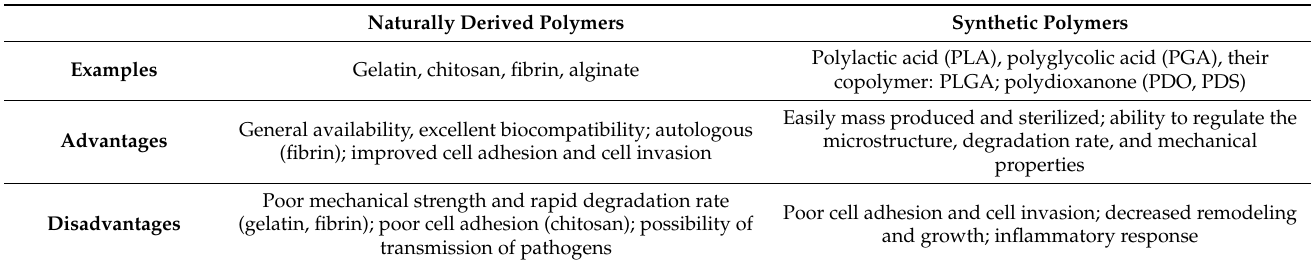
Table 2. Naturally derived vs. synthetic